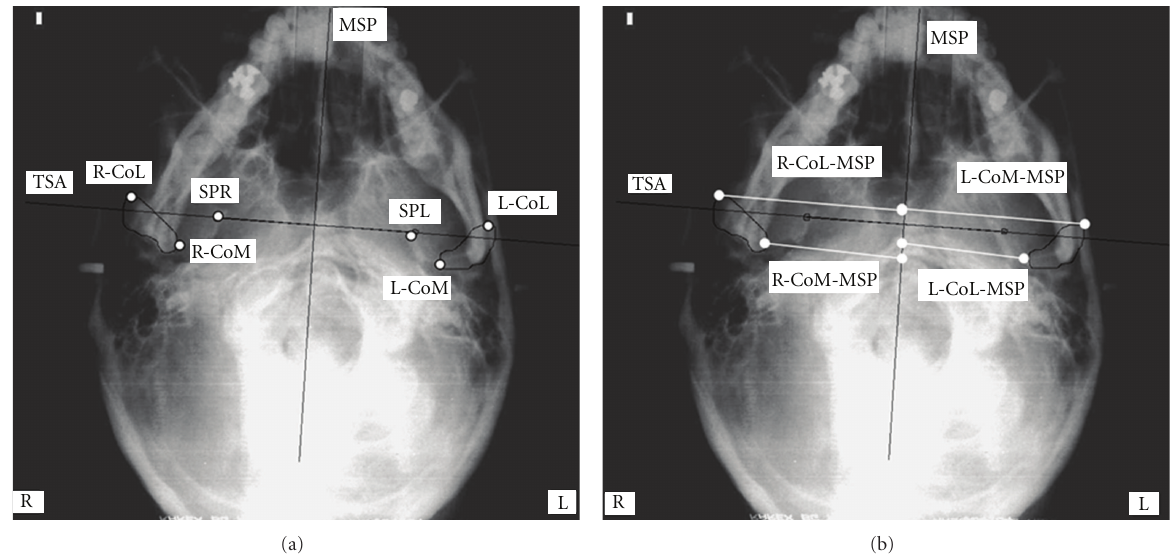
Figure 3: (a-b) Anatomic landmarks and reference planes used in submentovertex cephalometric analysis (Tracing 2). SPR, right foramen spinosum: geometric centre of right foramen spinosum; SPL, left foramen spinosum: geometric centre of left foramen spinosum; TSA, transspinosum axis: line passing through the geometric centre of right and left spinosum points; MSP, midsagittal axis: perpendicular bisecting TSA; RCoL, right condylion lateralis: most lateral aspect of right condyle; RCoM, condylion medialis: most medial aspect of right condyle; LCoL, left condylion lateralis: most lateral aspect of left condyle; LCoM, left condylion medialis: most medial aspect of left condyle; RCoL-MSP, right condylion lateralis-midline: distance from right L-point to MSP; RCoM-MSP: right condylion medialis-midline: distance from right M-point to MSP; LCoL-MSP, left condylion lateralis-midline: distance from left L-point to MSP; LCoM-MSP, left condylion medialis-midline: distance from left M-point to